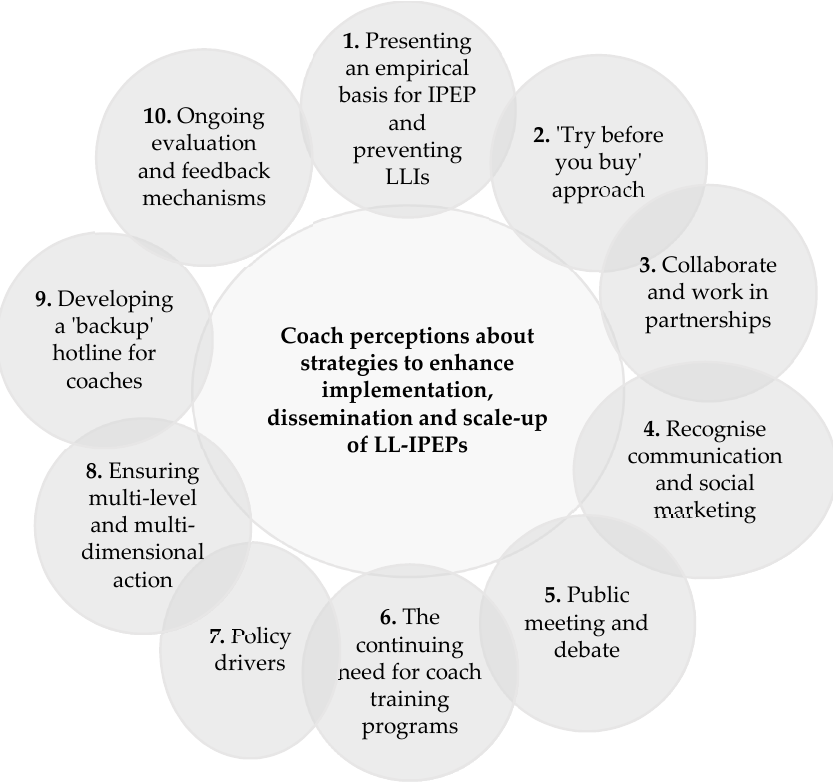
Figure 1. Coach perceptions about strategies to enhance implementation, dissemination and scale-up of LL-IPEPs: lower-limb injury-prevention exercise programs. LLIs: lower-limb injuries.